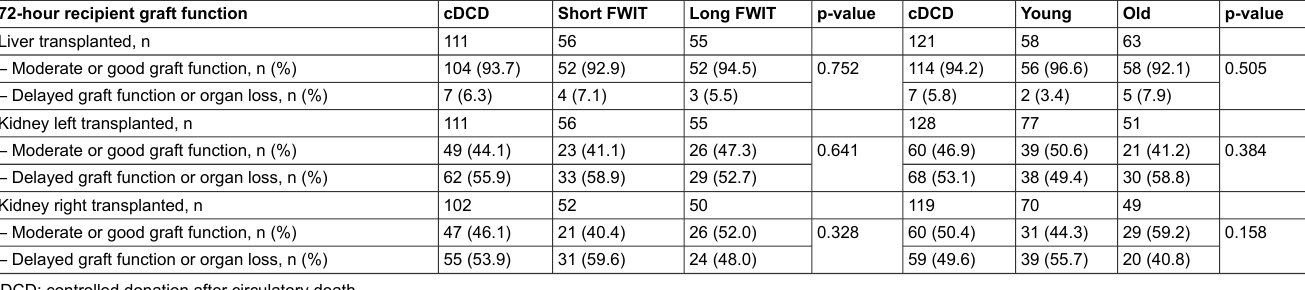
Table 3: Functional warm ischaemia time (FWIT) and age distribution of transplants from cDCD donors. 72-hour recipient graft